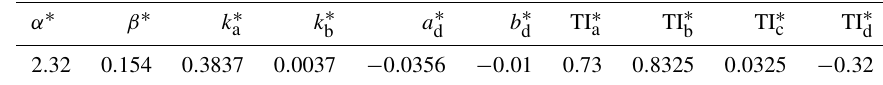
Figure 11. The 3D view of the Sedini wind farm with terrain elevation, as seen from (cid:48) = 260 ◦ . Table 6. Initial FLORIS parameters for the Sedini wind farm.